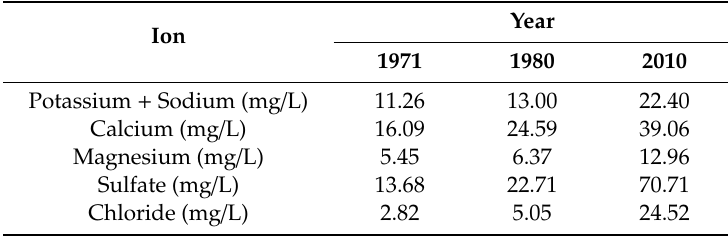
Table A2. Historical data of average concentrations of the main ions in the Taizi River. Data obtained from the Hydrological Yearbook of the Liaohe River Basin,